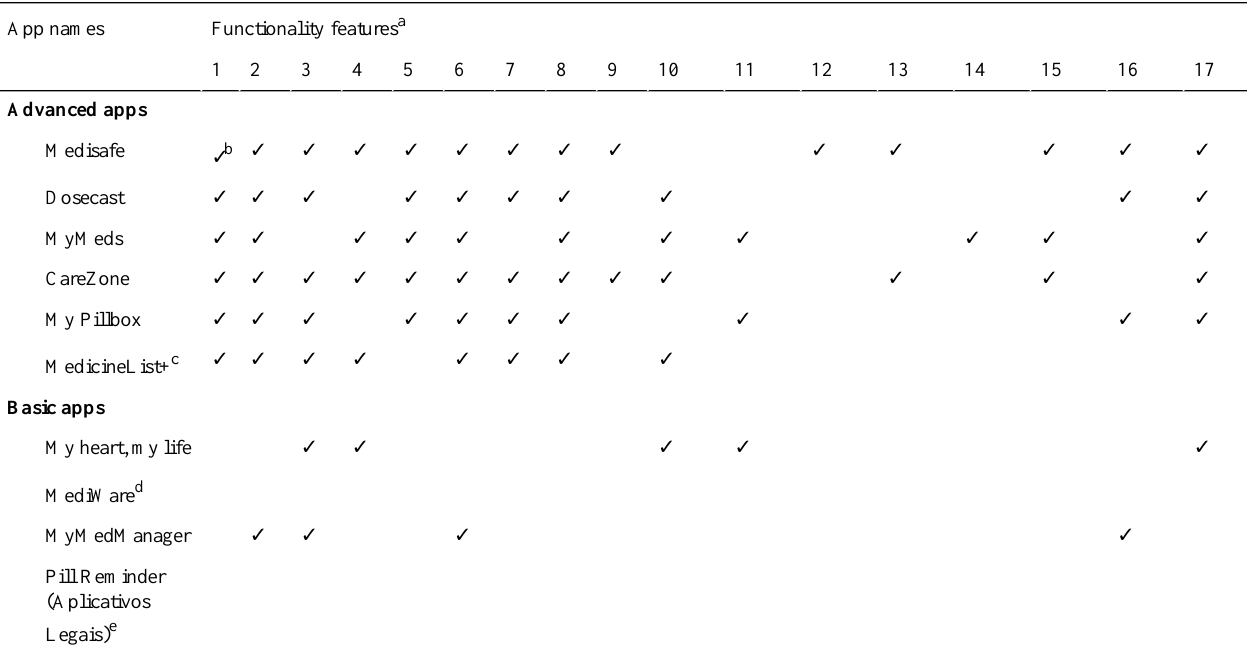
Table 3. Functionality features present in the top advanced and basic medication reminder